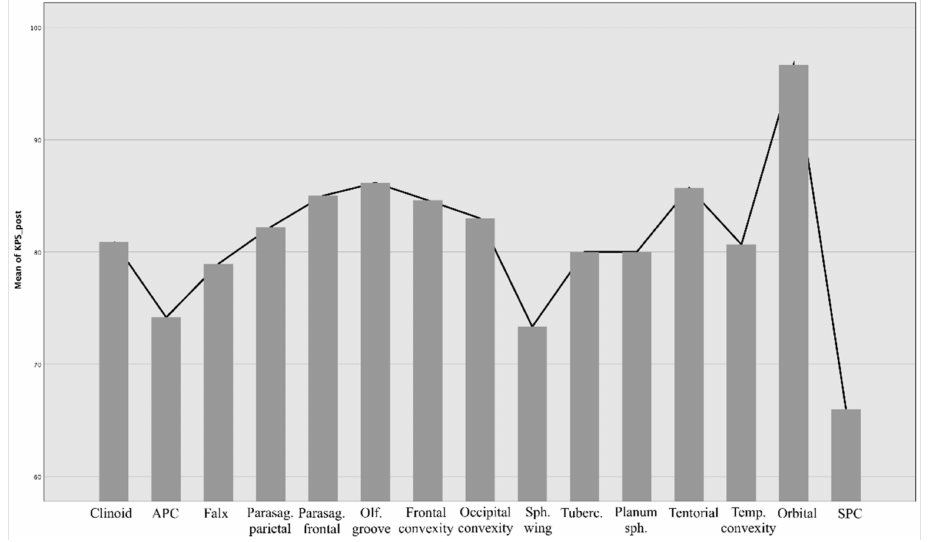
Figure 7. Measures of outcome, reported as KPS value, in the early postoperative phase according to different